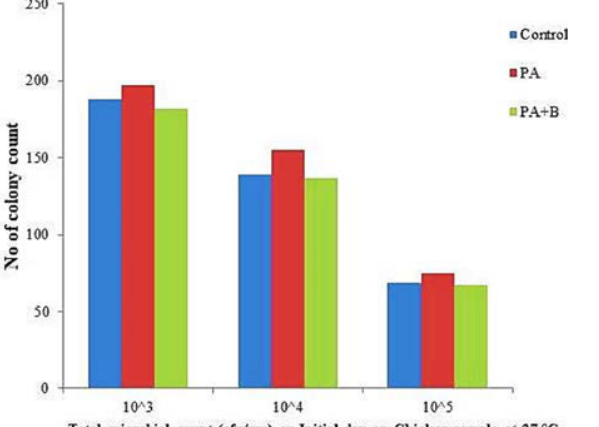
Fig. 2.1. Total Microbial count of chicken meat sample treated with strain and phage on Initial day